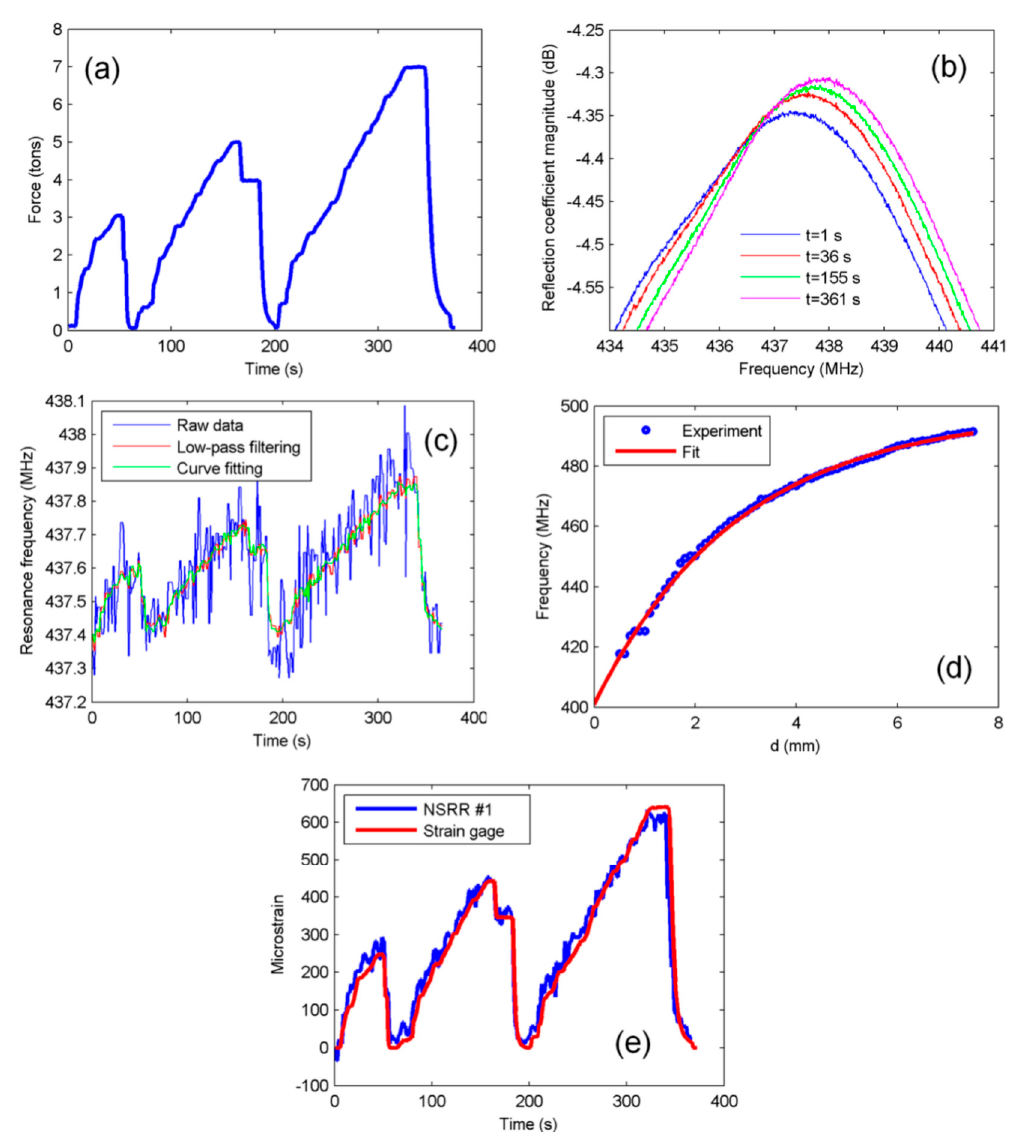
Figure 4. Elastic deformation region experiment results of NSRR #1: ( a ) applied vertical force read from the load cell; ( b ) NSRR #1 resonance frequency peaks with strain forming due to applied load at several time instants; ( c ) NSRR #1 peak frequency plotted by using the raw reflection coefficient data ( blue ), after a low-pass filter is applied to the raw data ( red ), and after 5th degree polynomial fitting is applied to the raw data ( green ); ( d ) a typical transformation curve (in air medium) obtained before the beam experiments by a controlled translational stage, which is used for converting the frequency shift into displacement and strain; and ( e ) strain obtained by the NSRR #1 plotted versus time, and compared to the data from the strain gages.